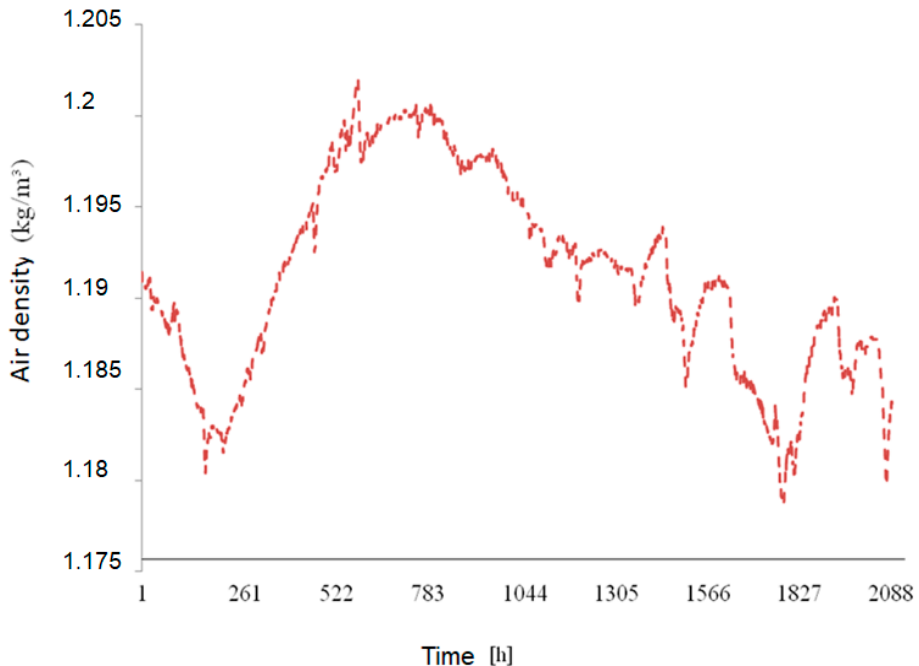
Figure 10. Air density in the analyzed building.